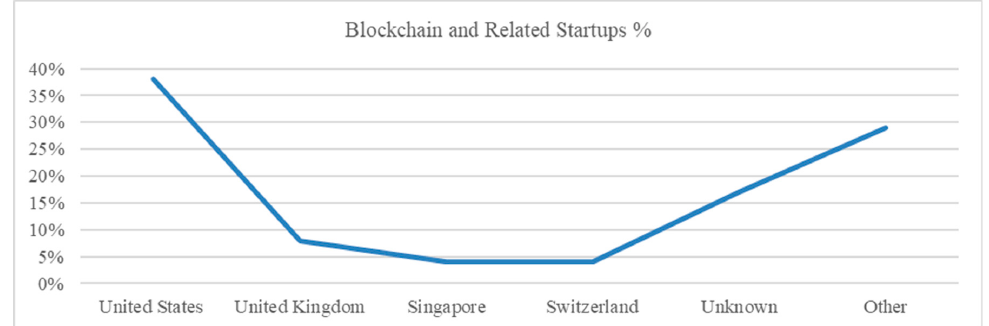
Figure 8. Percentage of Blockchain and related start-ups by geography between 2017 and end of February 2018. Source: CB insights, PwC, ICO Insights and Token Data.